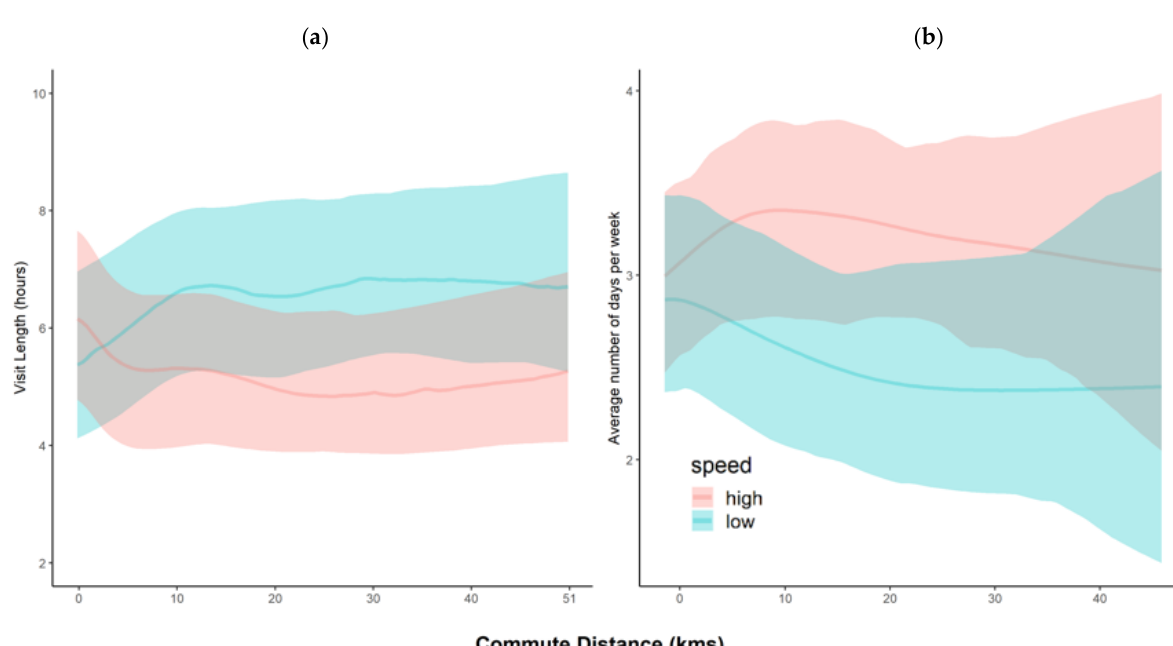
Figure 3. Posterior distribution of predicted ( a ) visit length and ( b ) visit frequency as a function of commute distance (kms) for average high (red) and low (blue) speed commutes. Shading represents 95% credible intervals.